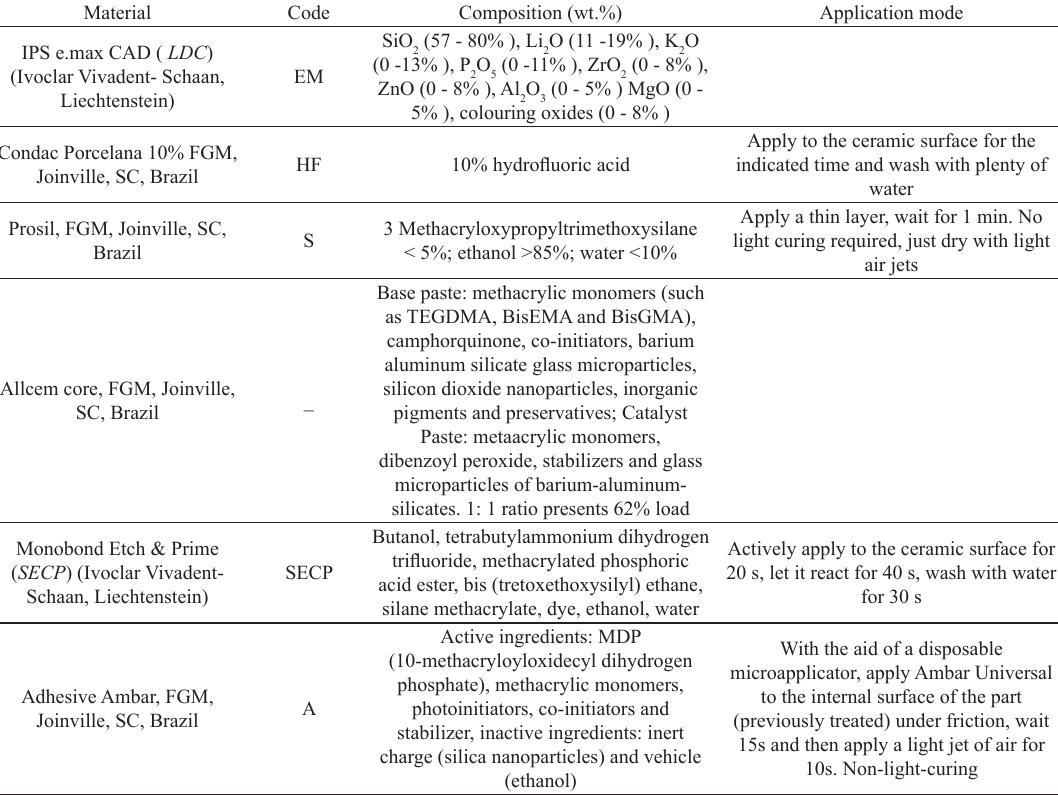
Table 1. Technical specifications and main characteristics of the materials used (data from the manufacturers).